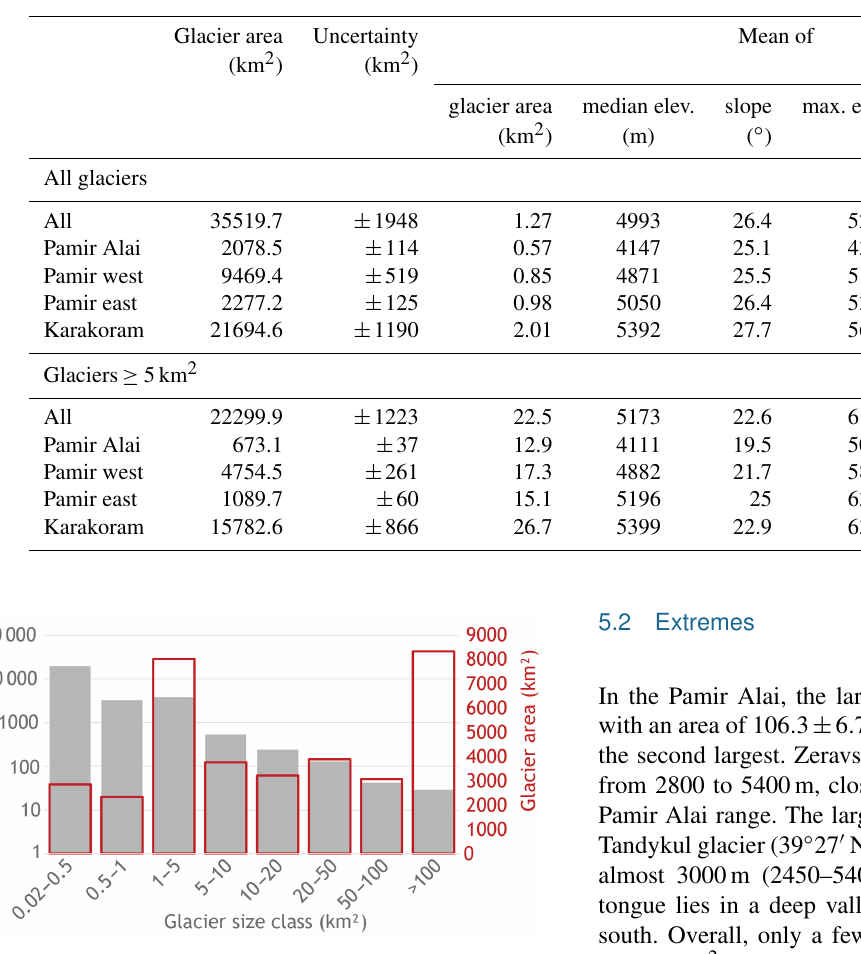
Figure 7. Histogram of all glaciers by number. Please note the log- arithmic scale of the left y